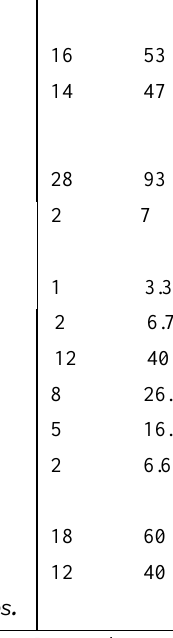
Table 6. Interview Result from Respondent